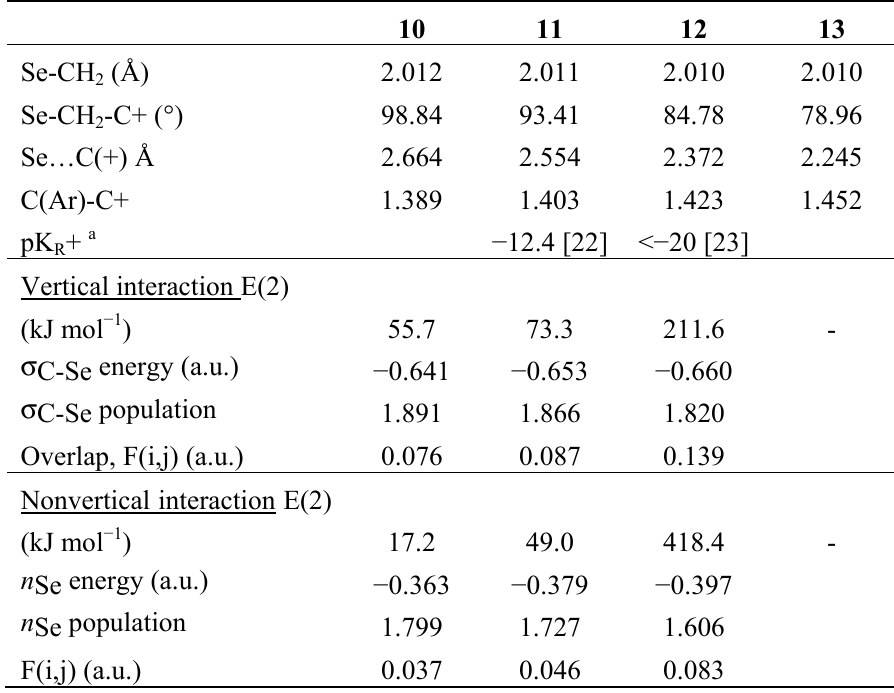
Table 1. Structural and orbital properties, and NBO interaction energies of β -selenium substituted 1-phenylethyl cations 10 – 13